Question: Judging by this figure, is the value going up or going down?
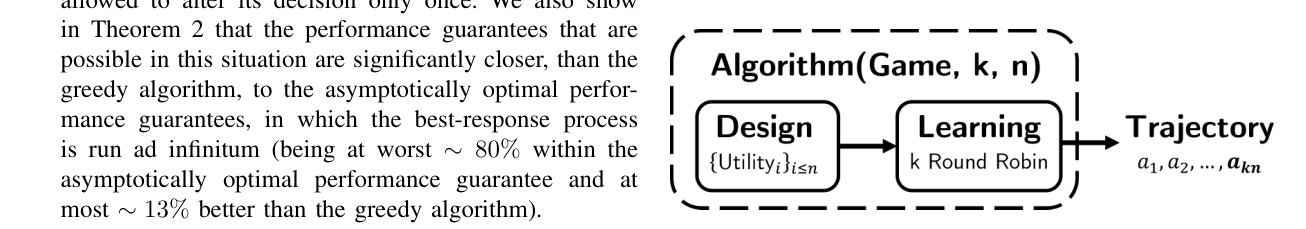
Answer: increasing